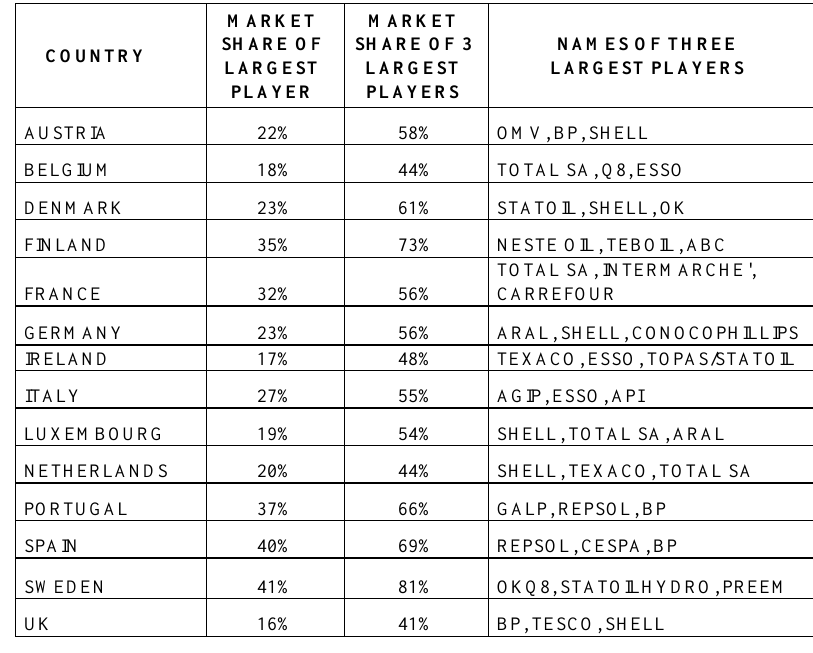
Figure 7: Largest Players in the Motor Fuel Retail Market –